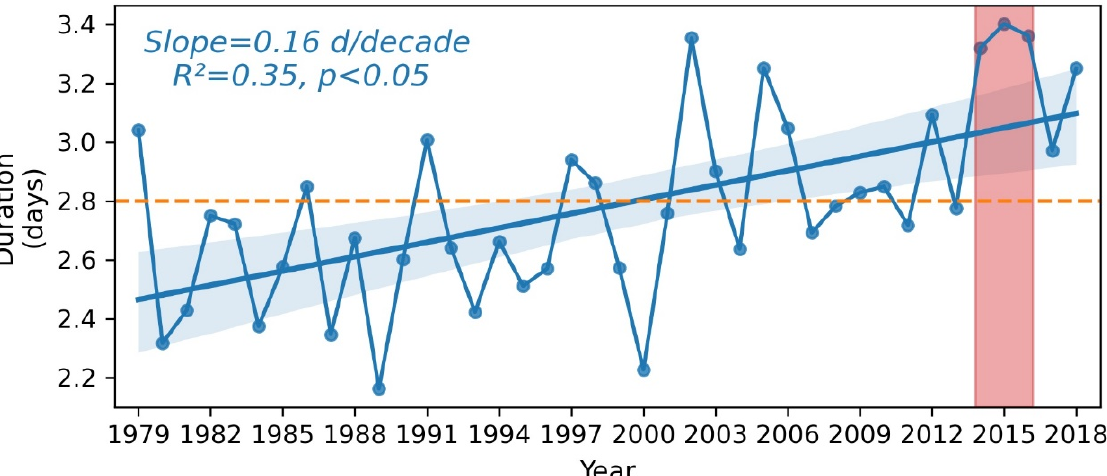
Figure 12. Duration variations of heatwave events in the 1979–2018 period across China. The orange dashed line denotes the mean duration of heatwave events during the study period; the shadowed area in blue represents a 95% confidence interval for the fitting line of all durations, while the shadow in red shows the period of relatively higher durations in recent years.